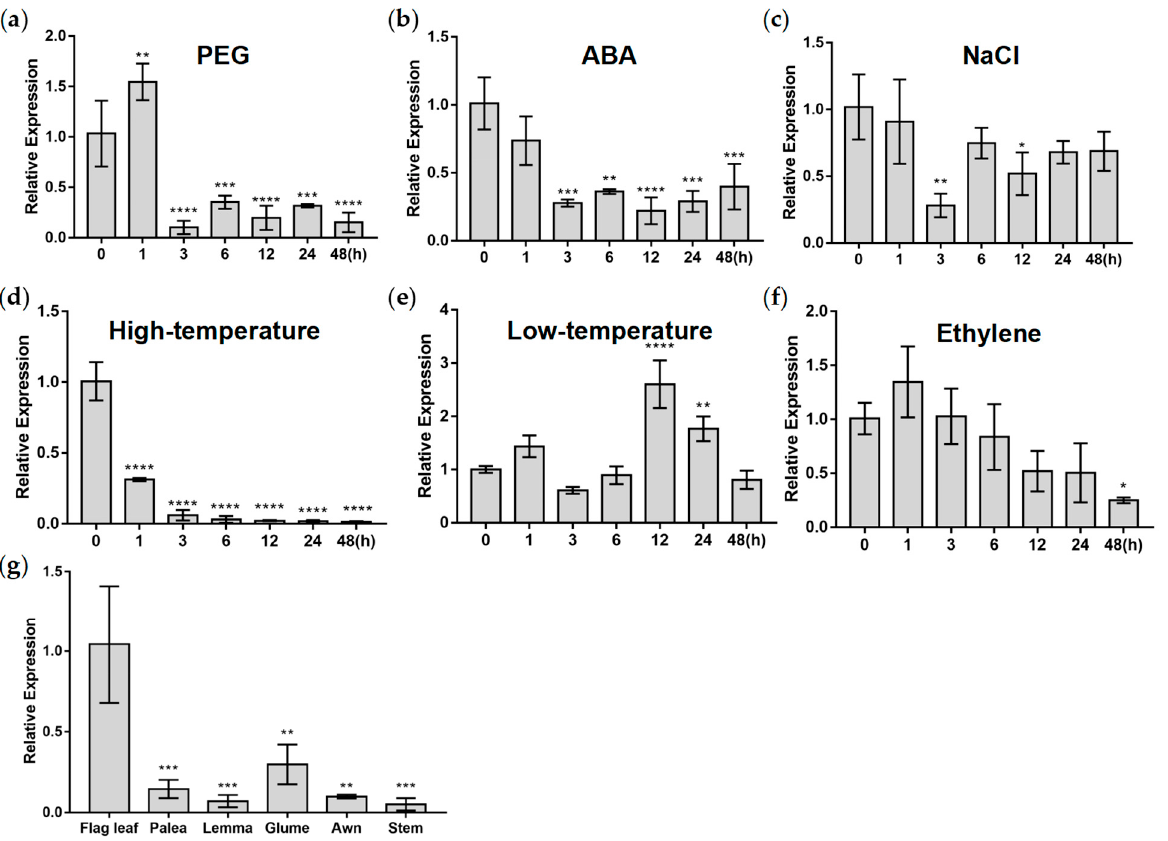
Figure 2. Expression pattern analysis of TaWRKY133 . Relative expression of TaWRKY133 under 20% PEG ( a ), 100 μ M ABA ( b ), 100 mM NaCl ( c ), 42 °C ( d ), 4 °C ( e ) and 100 μ L·L − 1 ethylene ( f ) treatment. ( g ) Expression pattern analysis of TaWRKY133 in different wheat organs. Asterisks indicate significant differences (* p < 0.05, ** p < 0.01, *** p < 0.001 and **** p < 0.0001). No asterisk means non-significant difference .